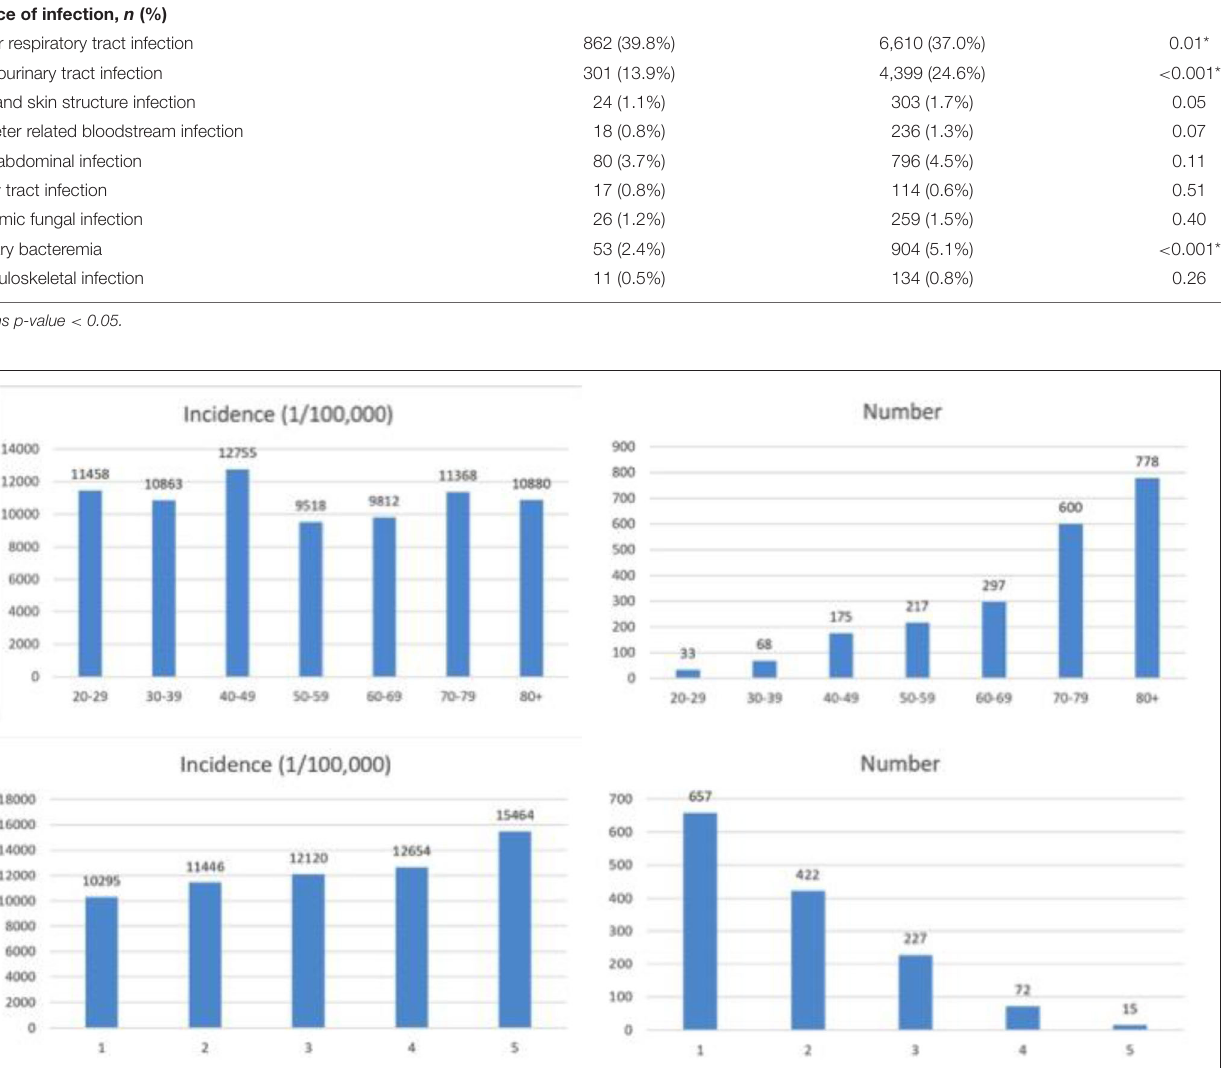
regression analysis; these were a respiratory failure, male gender, diabetes with complications, 10-year increase in age, and